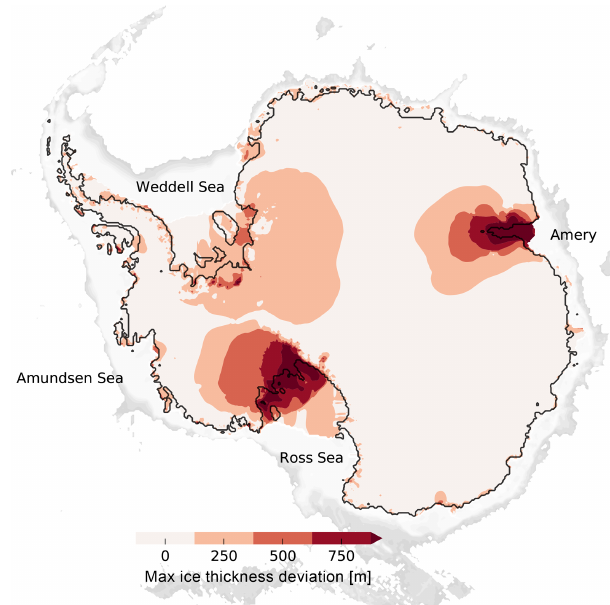
Figure 2. Maximum difference in present-day ice thickness of three simulations of the Antarctic Ice Sheet after three rounds of two- glacial-cycle simulations with identical model settings but for dif- ferent initial enthalpy states (cf. final state in Fig. 1). In particular the Siple Coast (Ross) and Amery trough show more than 1km dif- ference in ice thickness between the final